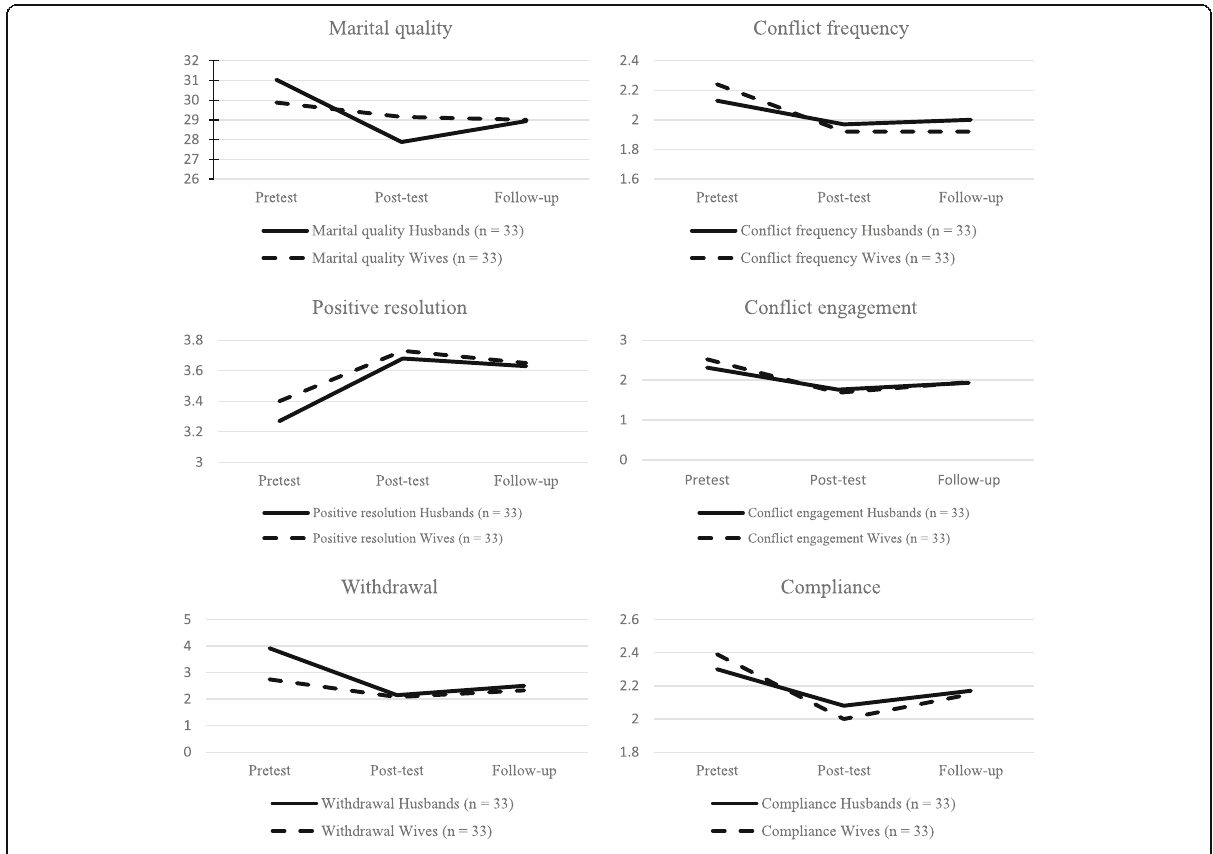
Fig. 2 Changes between pre-test, post-test, and follow-up evaluations